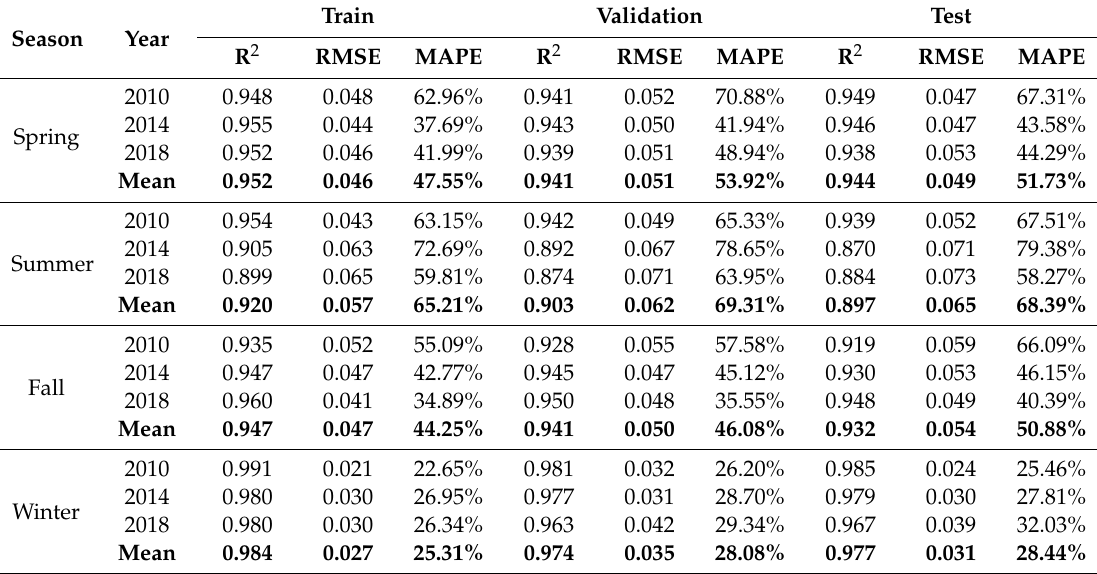
Table 3. The artificial neural network (ANN) model quality assessment using R 2 , root mean square error (RMSE), and mean absolute percentage error